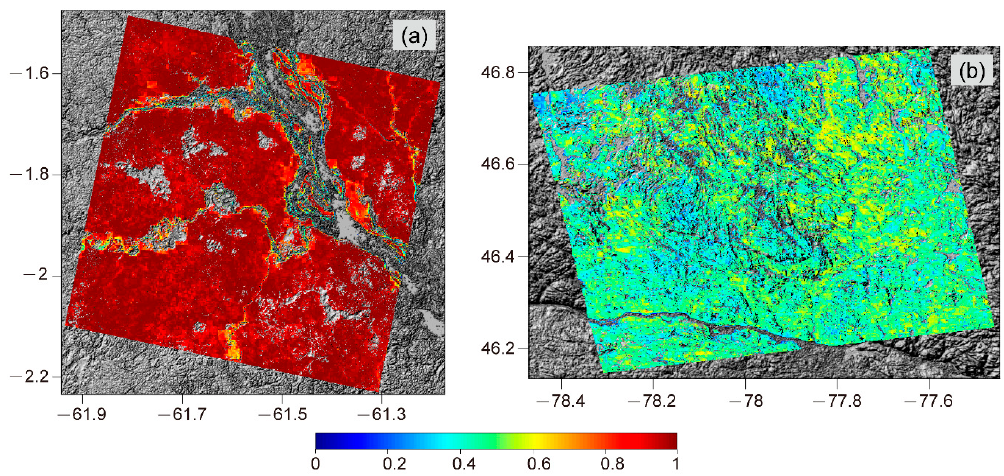
Figure 12. The fraction of vegetation cover (FVC) maps of ( a ) the tropical forest and ( b ) the boreal forest. Table 1. Standard regression coefficients for independent variables in the tropical and boreal forest